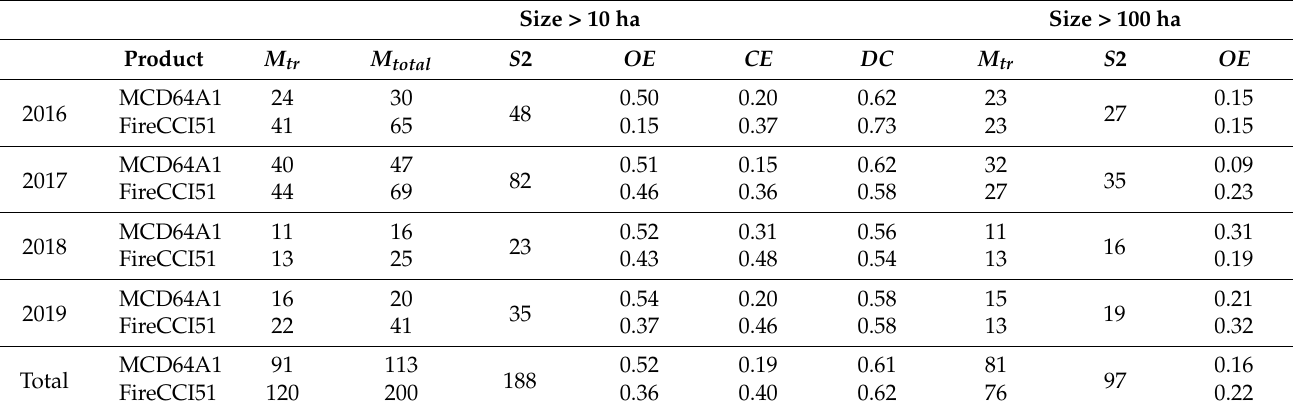
Table 1. Confusion matrix and accuracy metrics considering fire detections by MCD64A1 C6 and FireCCI51 in Greece (2016–2019). The dice coefficient ( DC ), omission ( OE ) and commission ( CE ) errors are estimated for all fires (>10 ha); only the OE is estimated for larger fires (>100 ha).